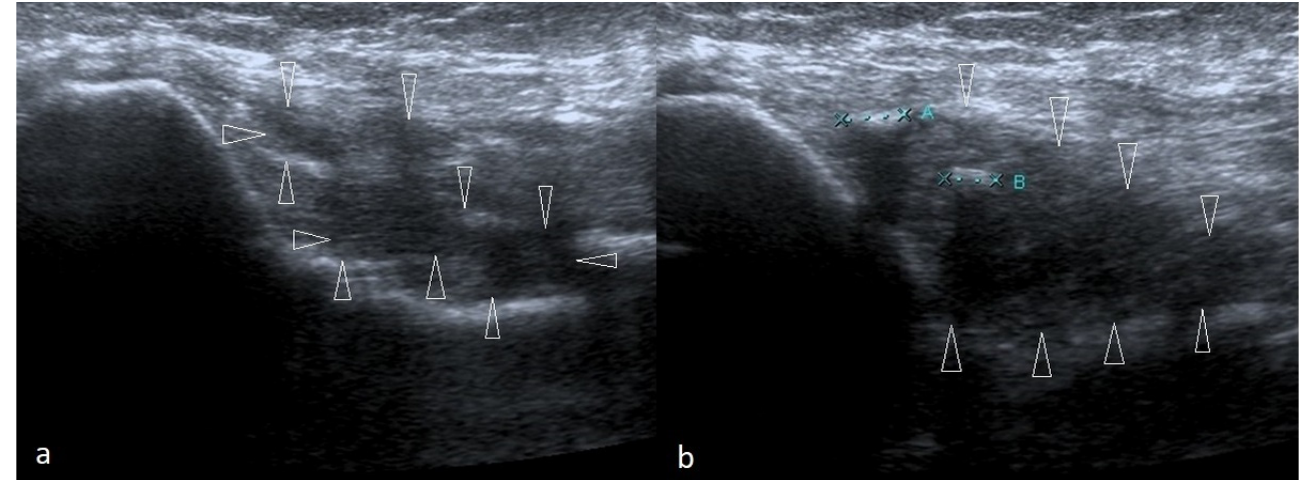
Figure 8. Two cases of post-traumatic changes within the medial collateral ligament and profound part of the common flexor tendon. In both pictures ( a , b ), the areas of hypoechoic scarring are marked with arrowheads; post-traumatic calcifications are also